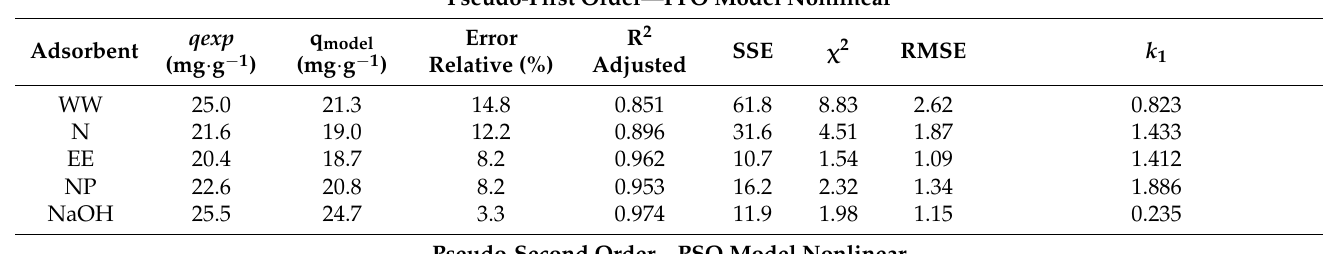
Table 2. Kinetic parameters Pseudo-first order, Pseudo-second order and Elovich model for all adsorbents.